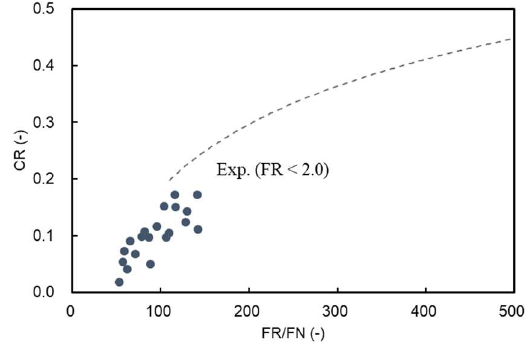
Figure 4. Relation between CR concentration and FR/FN of the samples.